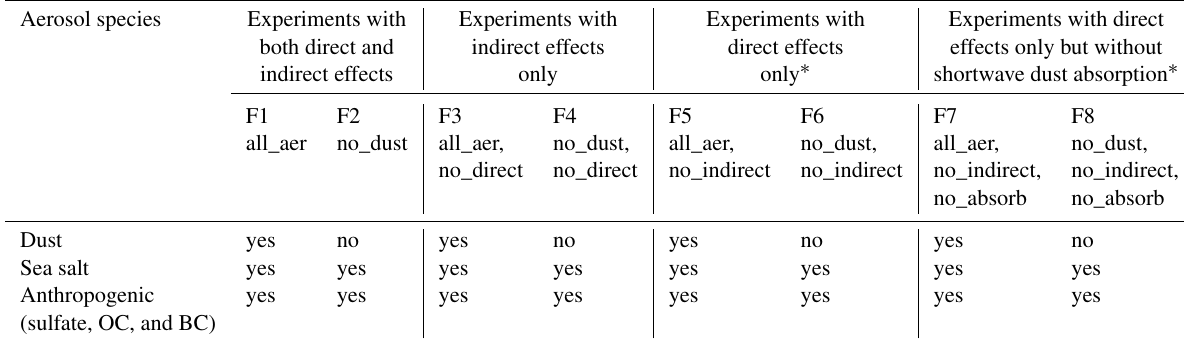
Table 2. WRF-Chem model experiments. Aerosol species Experiments with Experiments with Experiments with Experiments with direct both direct and indirect effects direct effects effects only but without indirect effects only only ∗ shortwave dust absorption